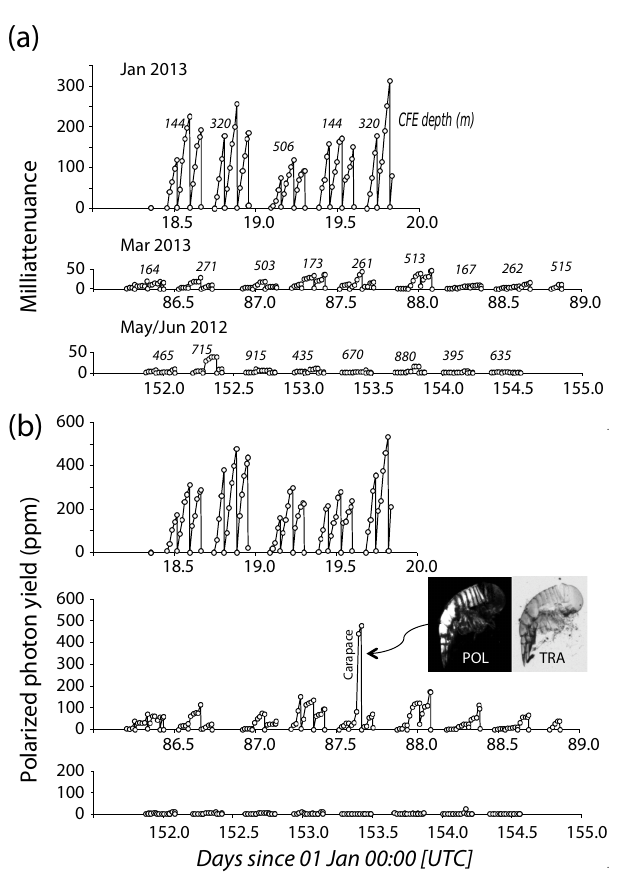
Figure 4. Results from CFE deployments in the Santa Cruz Basin. CFE depths shown in italics. Panel (a) : sample attenuance from transmitted light images. Panel (b) : polarized photon yield in parts per million from cross-polarized light images. Small circles denote the time that the images were taken. The sawtooth pattern regis- ters particle accumulation and drops to baseline at the time of stage